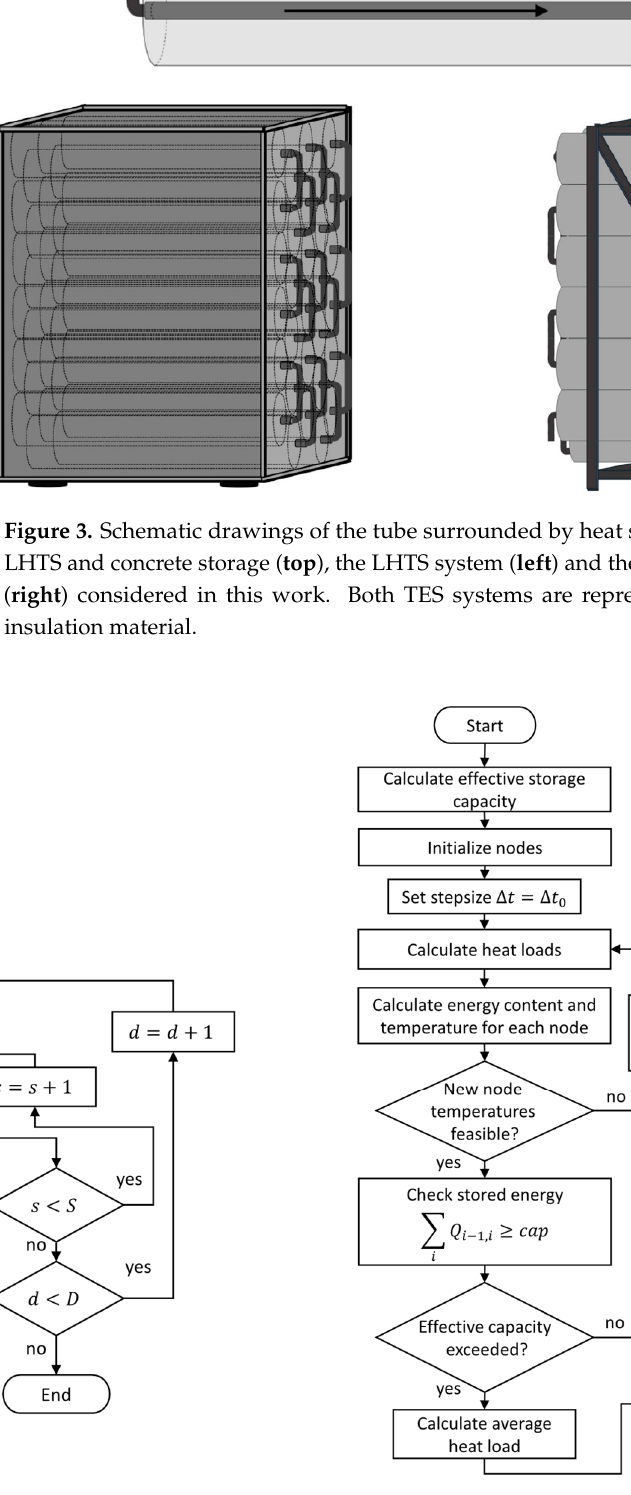
Figure 4. Flow-charts for the calculation of storage parameters for LHTS and concrete storages ( left ) and for the calculation of average heat loads ( right ).